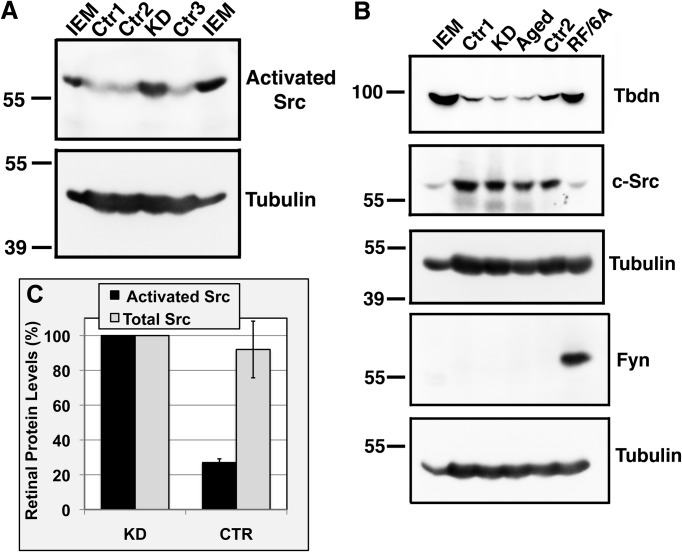
Increased activated c-Src levels in retina of endothelial specific Tbdn knockdown mice. (A,B) Representative western blots of retinal lysates from controls (CTR1, CTR2, CTR3), 6-week induced Tbdn knockdown (KD) and aged mice (Aged) were performed using the antibodies indicated. Note Tbdn suppression during aging (Gendron et al., 2010). Cell lysates from IEM mouse embryonic endothelial cells (IEM) and RF/6A retinal endothelial cells (RF/6A) were used as positive controls. Tubulin was used as loading control and for sample integrity. (C) Quantitative analyses of retinal lysate western blots for activated c-Src and total c-Src for which representatives are shown in two previous panels. Levels of activated c-Src are expressed as percent of the maximal levels observed in 6-week induced Tbdn knockdown mice. Means±s.e.m. of 3 experiments are indicated.